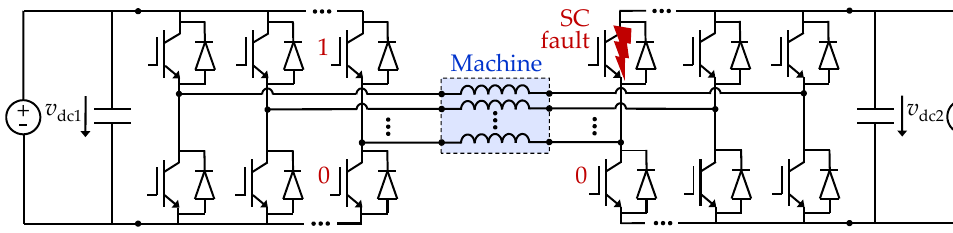
Figure 17. Tolerance to a switch SC by clamping both terminals of a stator phase through HB VSCs (no phase SC), as in [273].